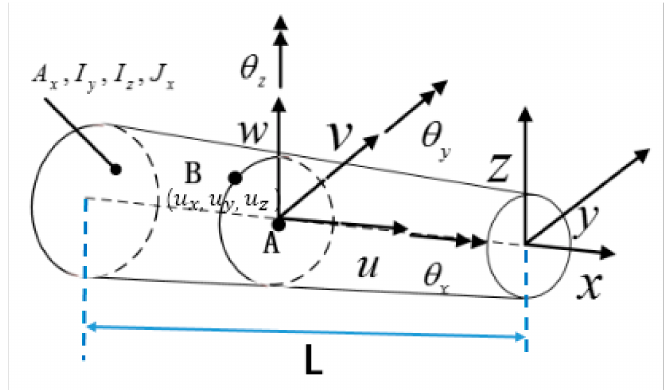
Figure 1. Schematic diagram of a variable section beam.